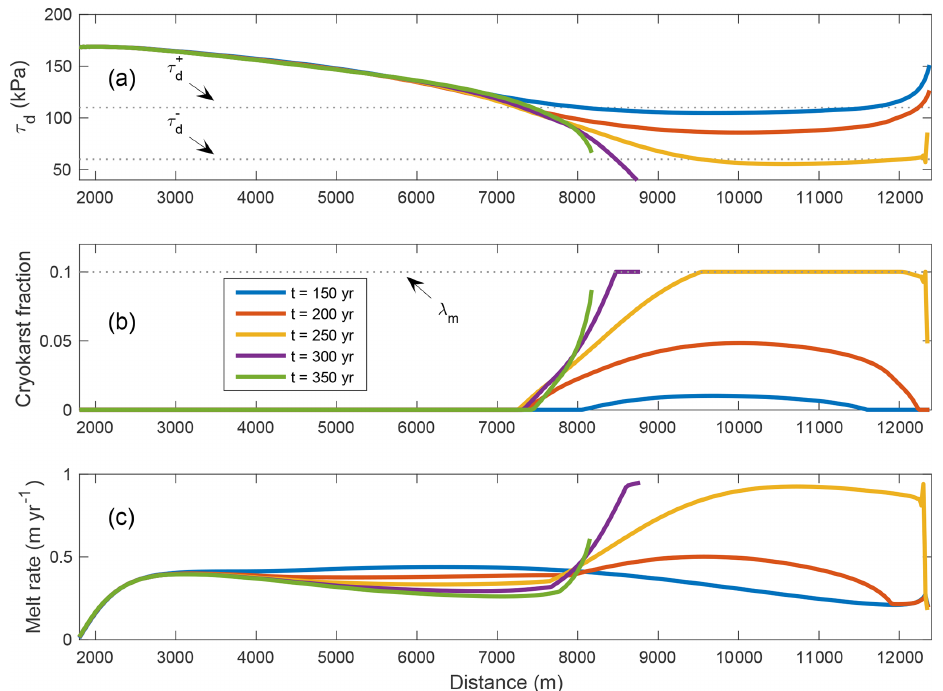
Figure 8. Profiles of driving stress (a) , cryokarst fraction (b) , and melt rate (c) at five different time steps for the case of maximum cryokarst area fraction λ m = 10%. The dashed lines in panel (a) denote the driving stress thresholds used in the cryokarst parameterization.